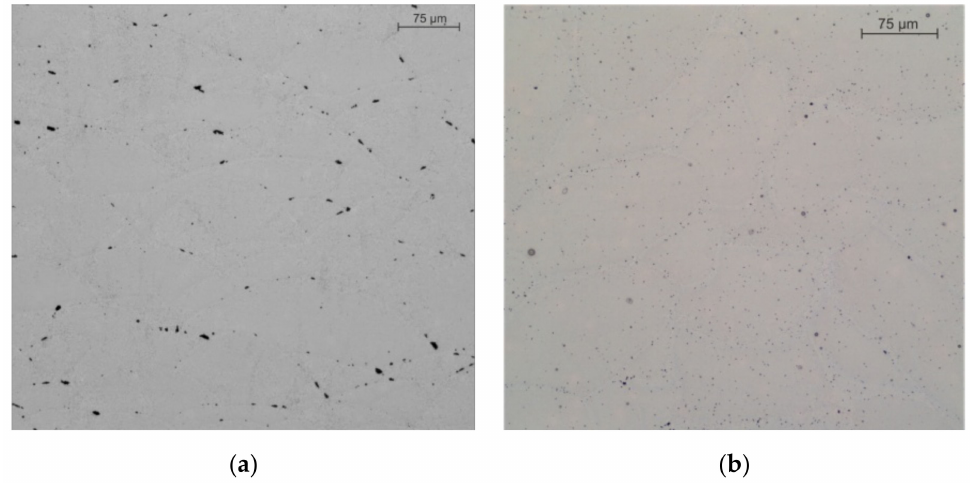
Figure 7. The structure of the synthesized AlSi10Mg alloy is presented along the Z–axis ( a ) and in the XY–plane ( b